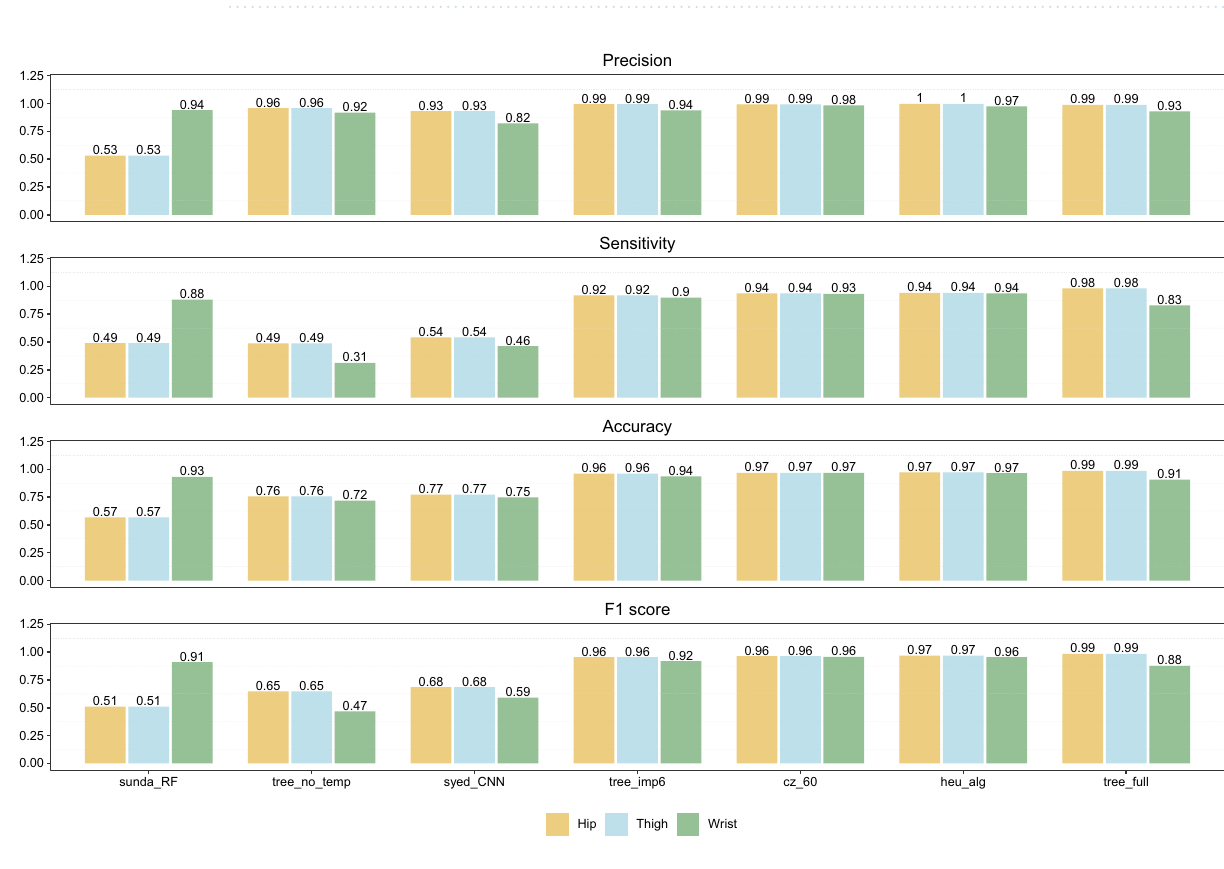
Figure 5. Classification performance metrics on all non-wear episodes for the seven included methods for classifying non-wear time. Metrics are shown for the three different ground-truth dataset including hip-worn, thigh-worn, and wrist-worn raw accelerometer